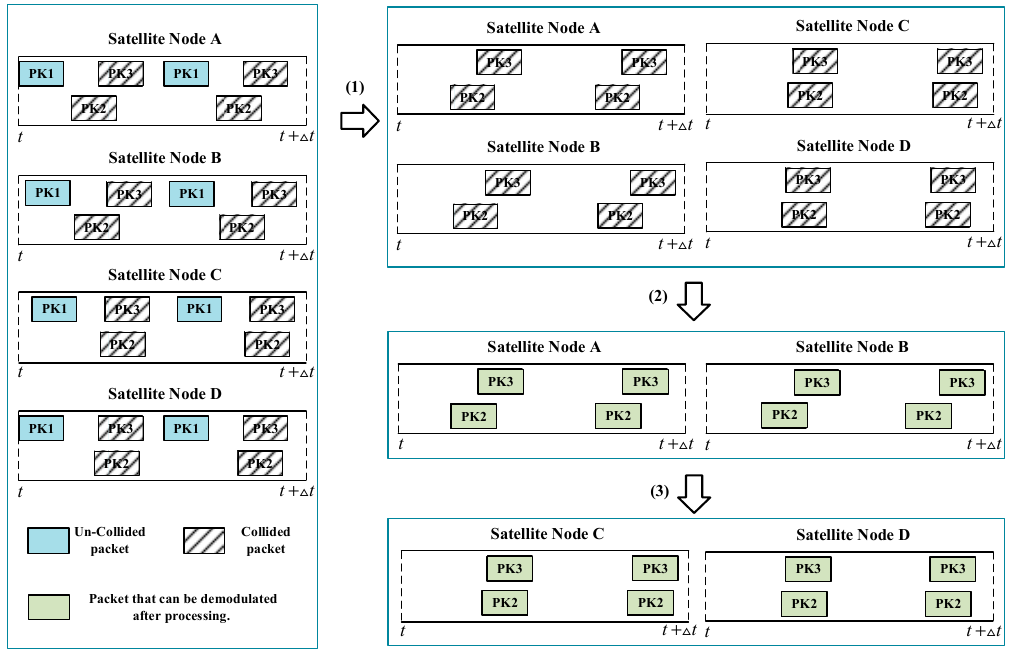
Figure 5. Packet processing flow chart.